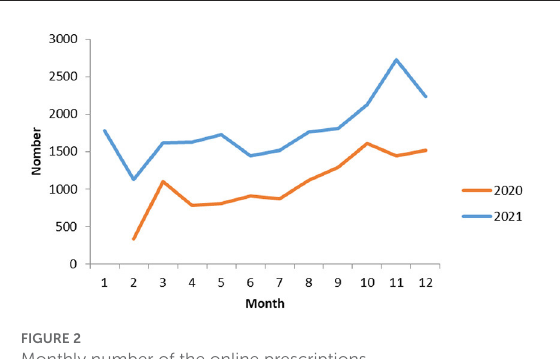
FIGURE2 Monthly number of the online